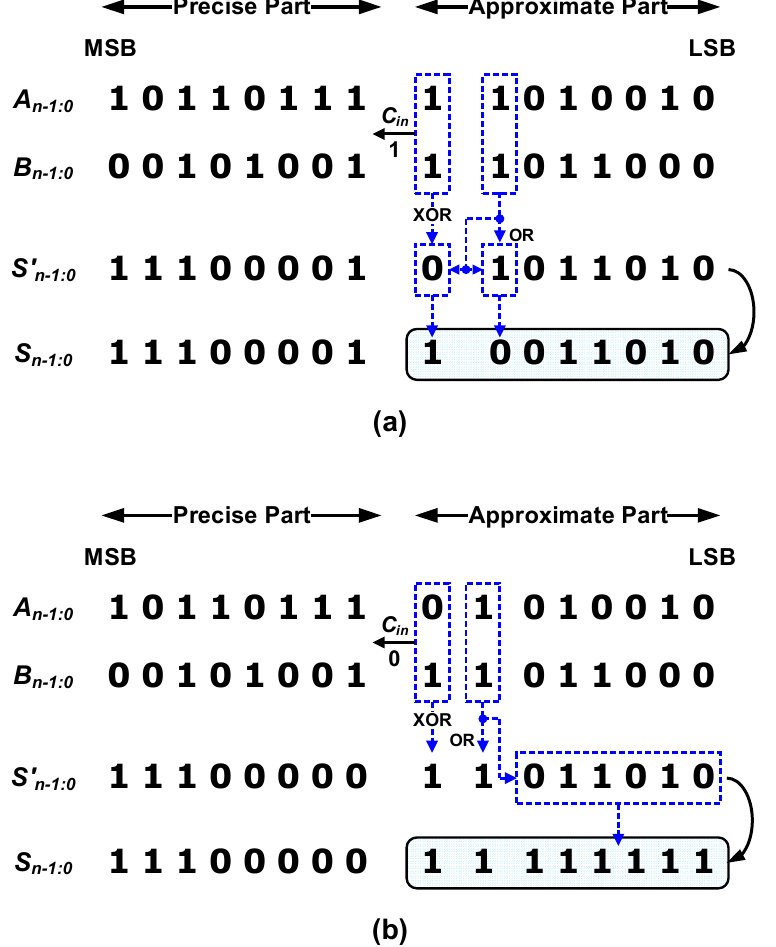
Figure 4. Operations of proposed error reduction when ( a ) A n − k − 1 and B n − k − 1 are identical and ( b ) A n − k − 1 and B n − k − 1 are exclusive.